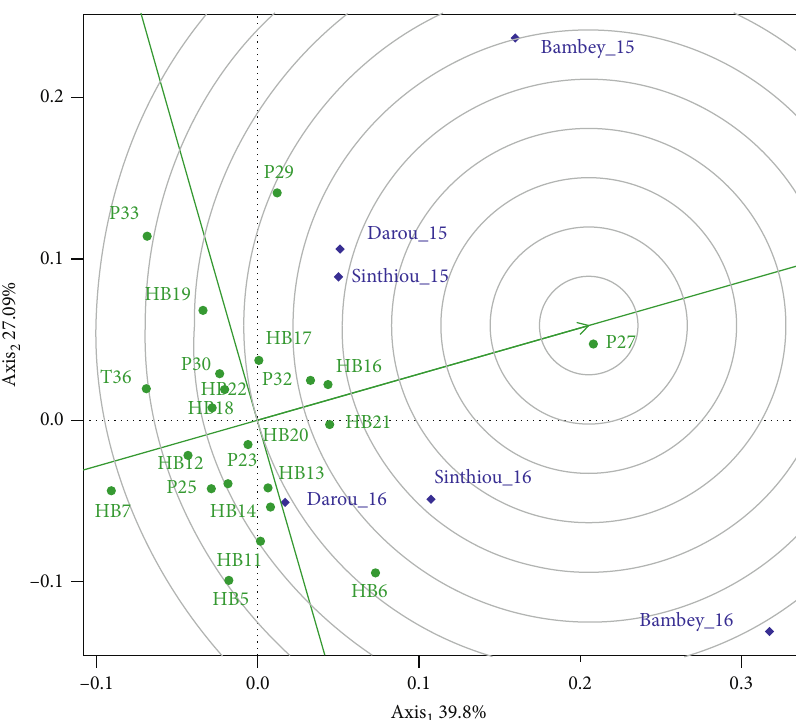
Figure 7: Ranking genotypes for grain mold resistance based on both mean performance and stability with reference to an “ideal” genotype. The green single-arrowed horizontal line represents the AEC abscissa, and the green vertical line represents the AEC ordinate. The AEC abscissa arrowhead indicates where an “ideal” genotype should be. Its projection on the AEA was designed to be equal to the longest vector of all genotypes, and its projection on the AEC was obviously zero, meaning that it is absolutely stable. Genotypes located closer to the ideal genotype are more desirable than others. The concentric circles help to visualize the position of the genotype with respect to ideal genotype. Genotype and environment labels are represented in green and blue,